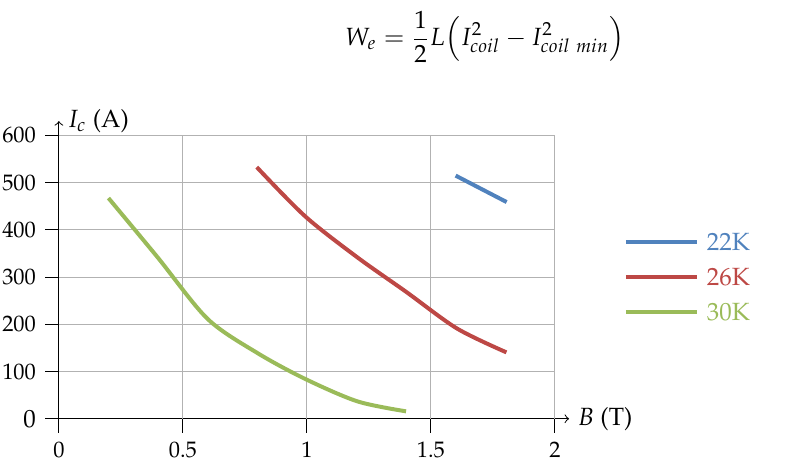
Figure 1. I c vs. B performance of the six-filament MgB 2 tape for temperatures of 22 K, 26 K and 30 K. Table 1. Main characteristics of the MgB 2 conductor.